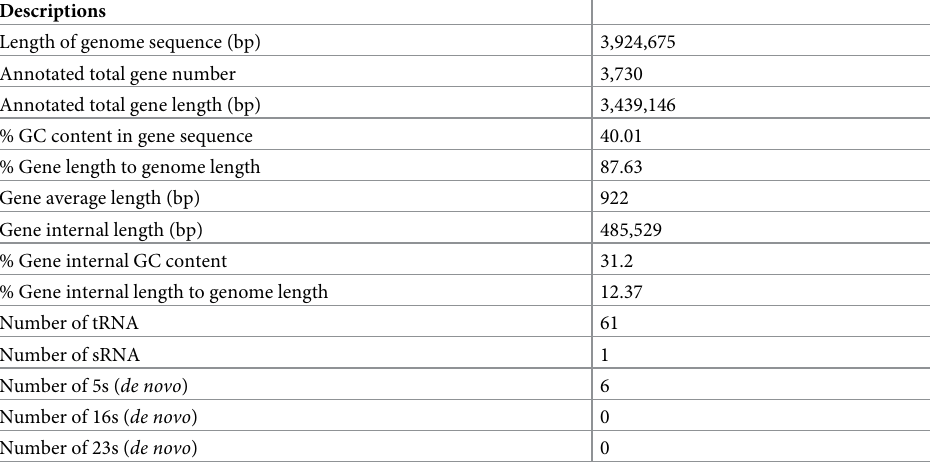
Table 2. Assemble and annotation of A . baumannii